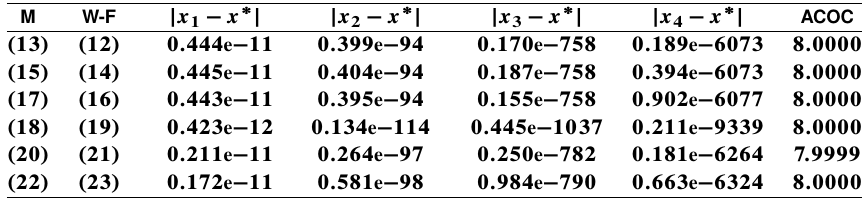
Table 2. Comparison for f.x/ D ln .1 (cid:0) x C x 2 / C 4 sin .1 (cid:0) x/;x (cid:3) D 1;x 0 D 1:1 , for different methods (M) and weight functions